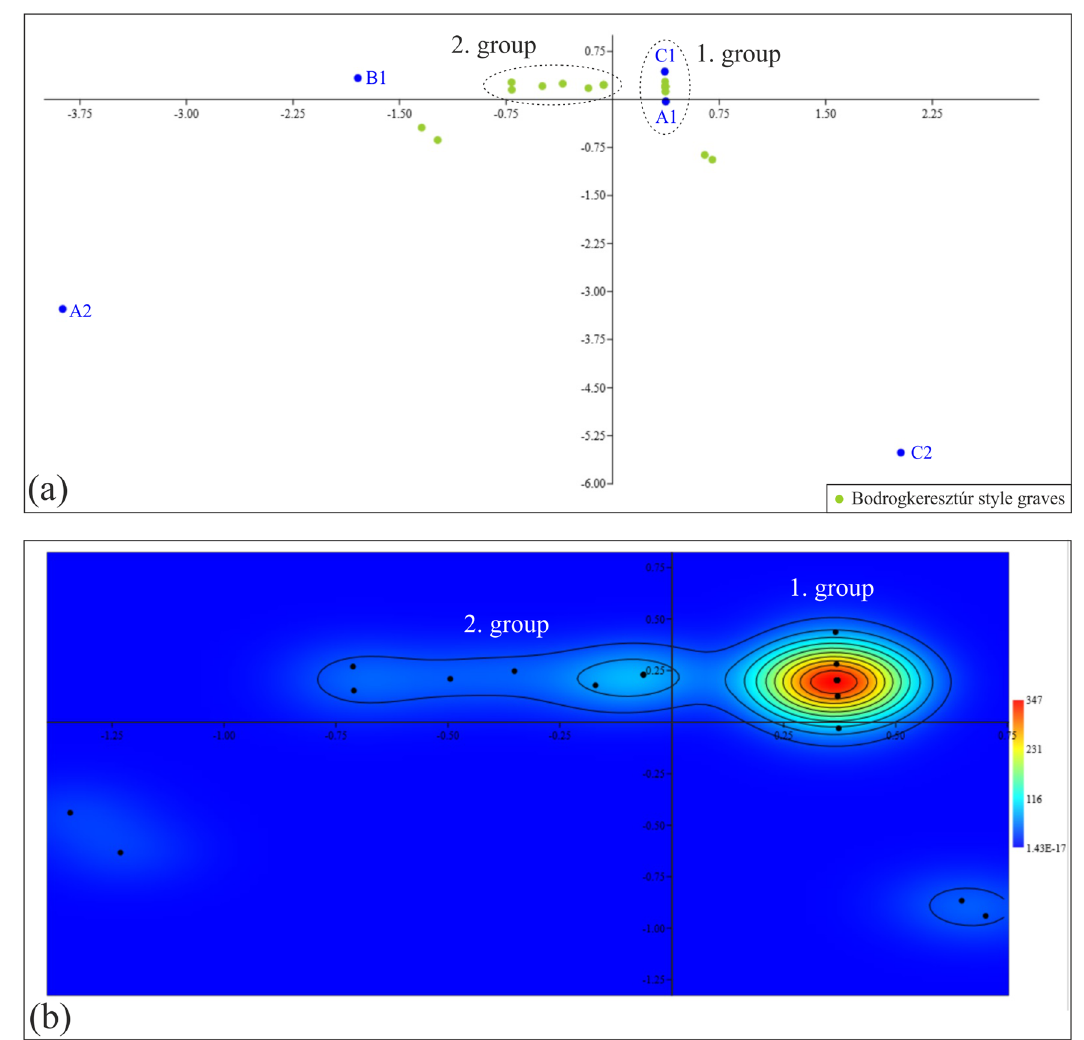
Figure 10: ( a ) Correspondence analysis of the graves from Tiszavalk - Kenderföld. ( b ) Kernel density plot generated from the correspondence analysis from Tiszavalk -